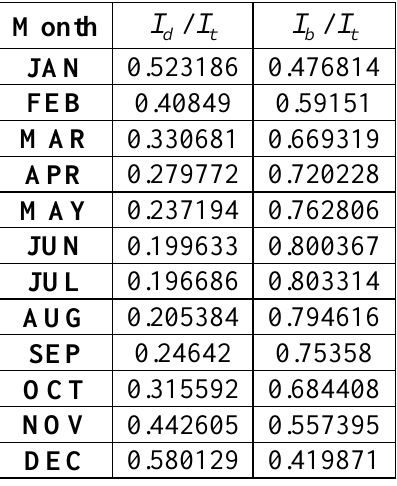
I I / and direct fraction t d